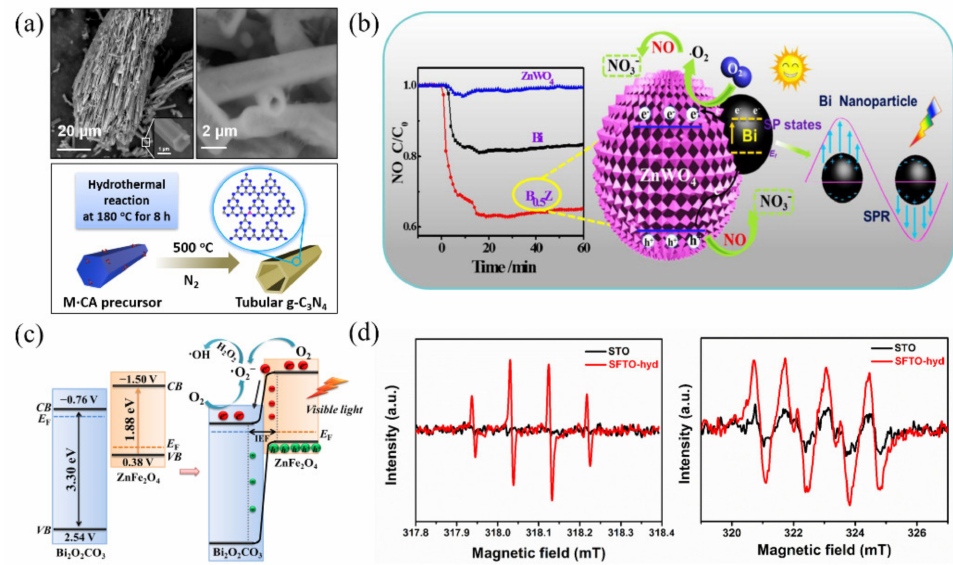
Figure 4. ( a ) B-doped graphitic carbon nitride hollow tubes. Reprinted with permission from the reference [64]. ( b ) Bi metal-induced surface plasmon resonance SPR effect with enhanced visible light ability. Reprinted with permission from the reference [67]. ( c ) Schematic illustration of e − -h + separation under the influence of the internal electric field of a p–n heterojunction photocatalyst under light irradiation. Reprinted with permission from the reference [69]. ( d ) Oxygen vacancy OV-enriched SrFe x Ti 1 − x O 3 − δ demonstrated enhanced O 2 adsorption activation ability for reactive oxygen species ROS generation. Reprinted with permission from the reference